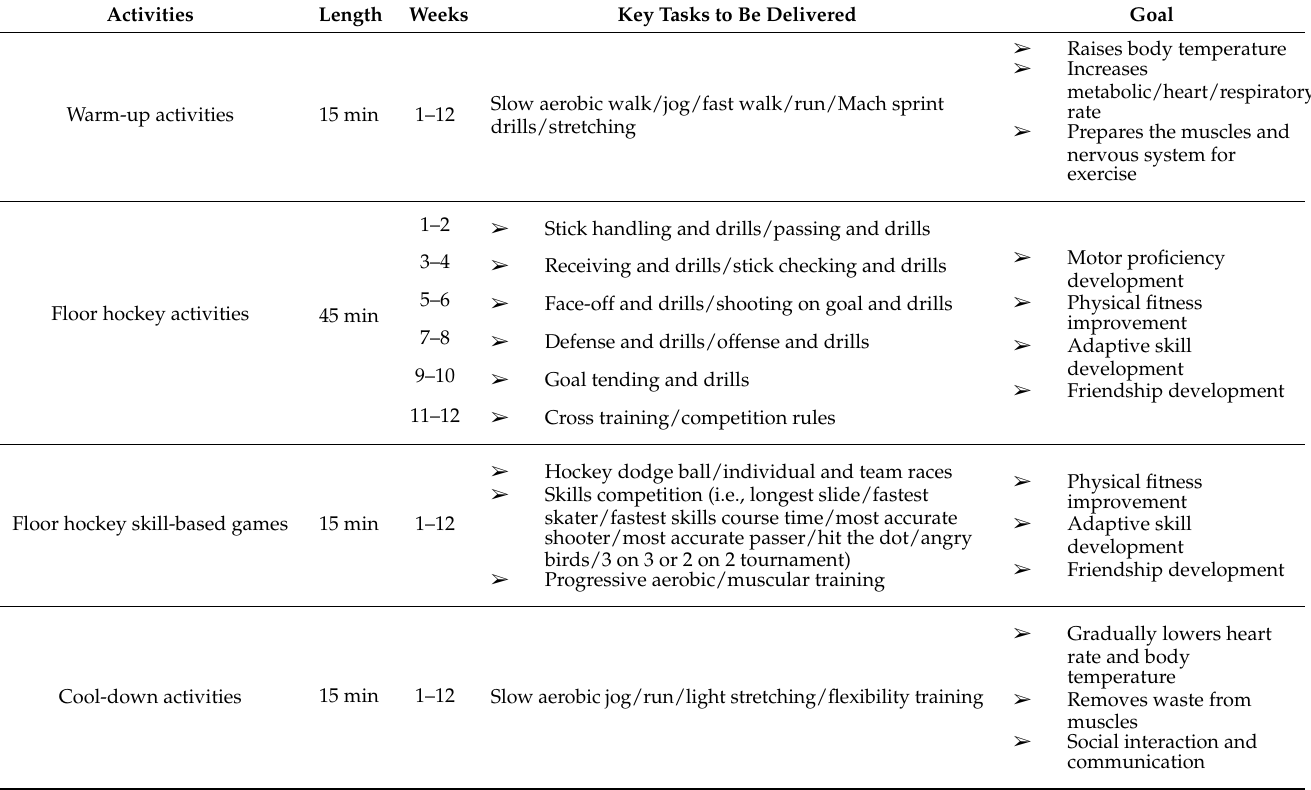
Table 2. Activities of a 90 min floor hockey lesson throughout the 12-week